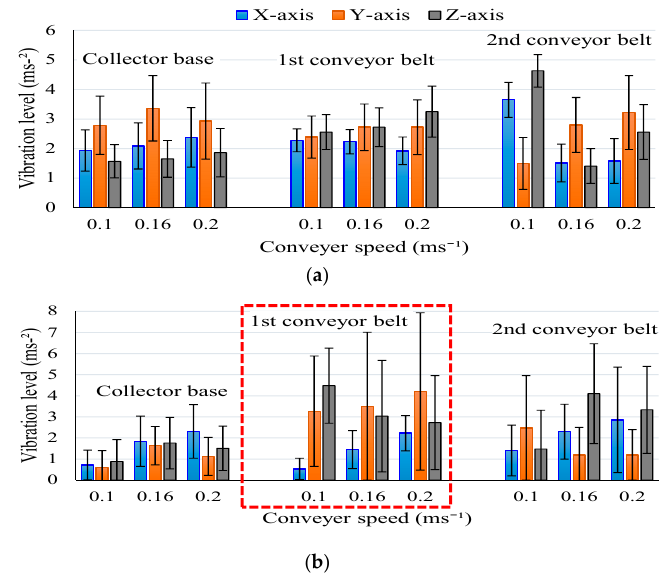
Figure 7. Maximum vibration levels in different positions of the radish collector and speeds of the conveyor belts during ( a ) unloaded condition and ( b ) loaded condition.